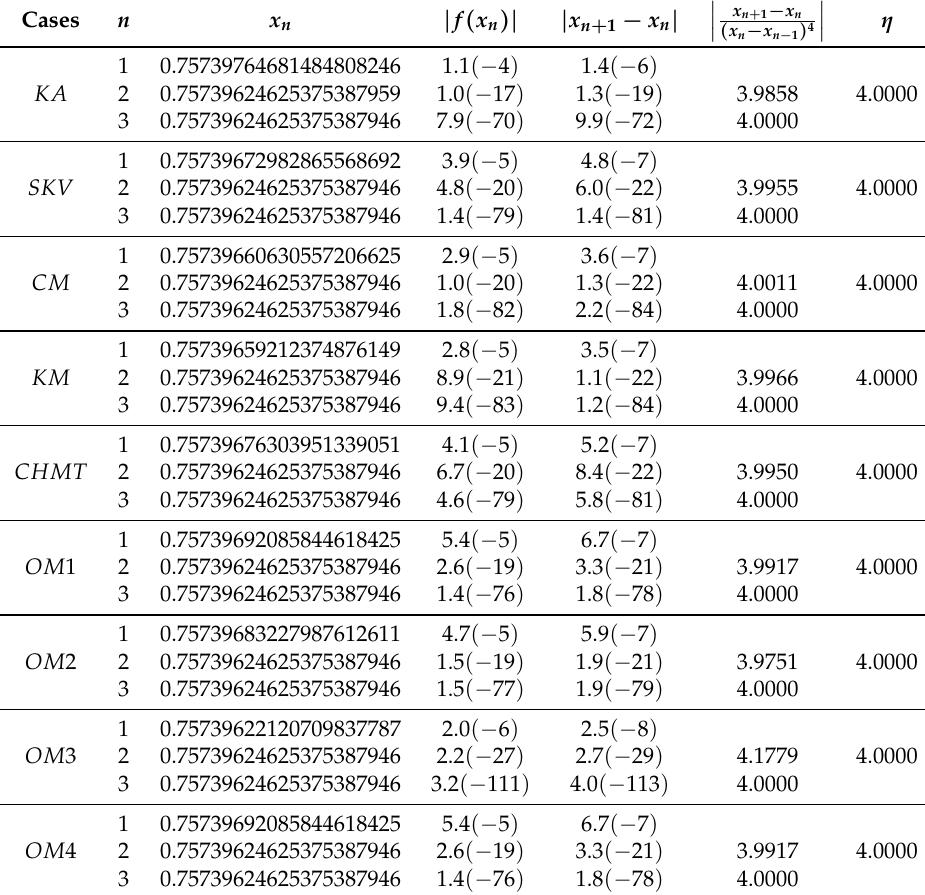
Table 6. Convergence behavior of different fourth-order optimal methods for f 4 ( x )